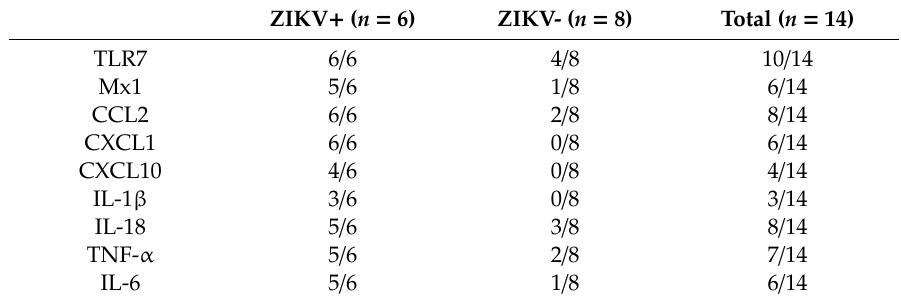
Table 3. Increased expression of inflammatory factors by the brain of embryos from ZIKV-infected dams.